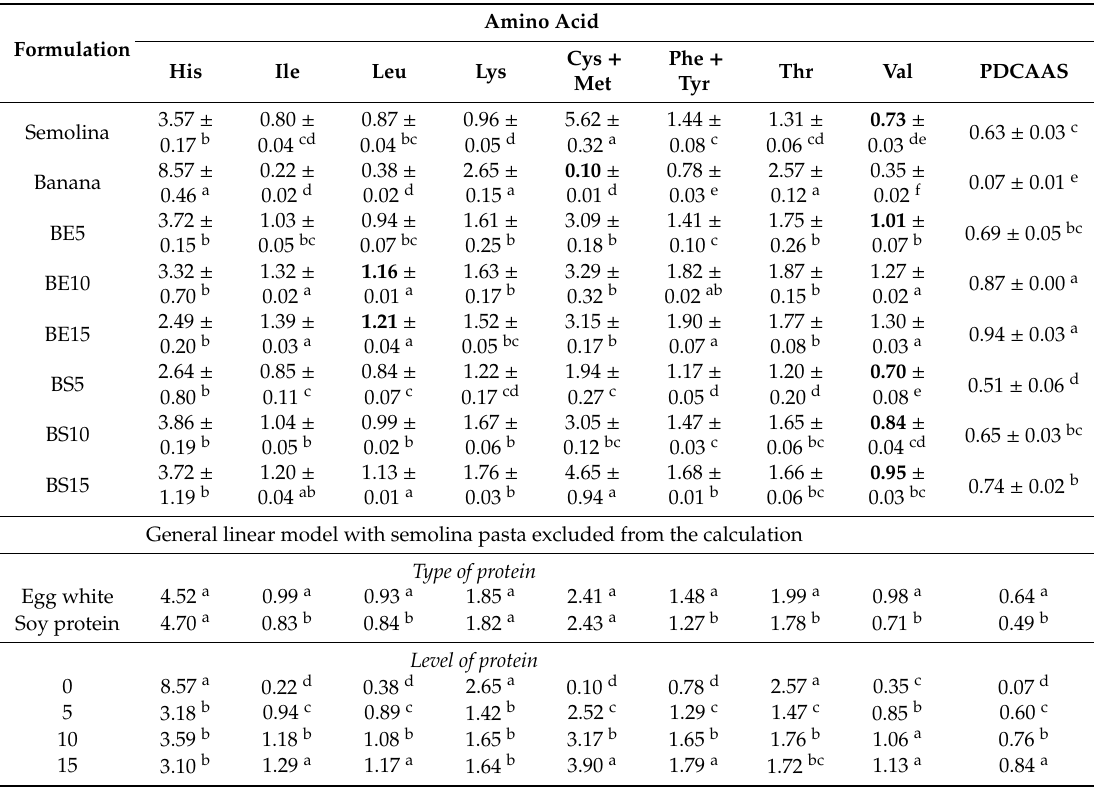
Table 4. Amino acid scores (AAS) (mg per g protein) and protein digestibility corrected amino acid scores (PDCAAS) of sample